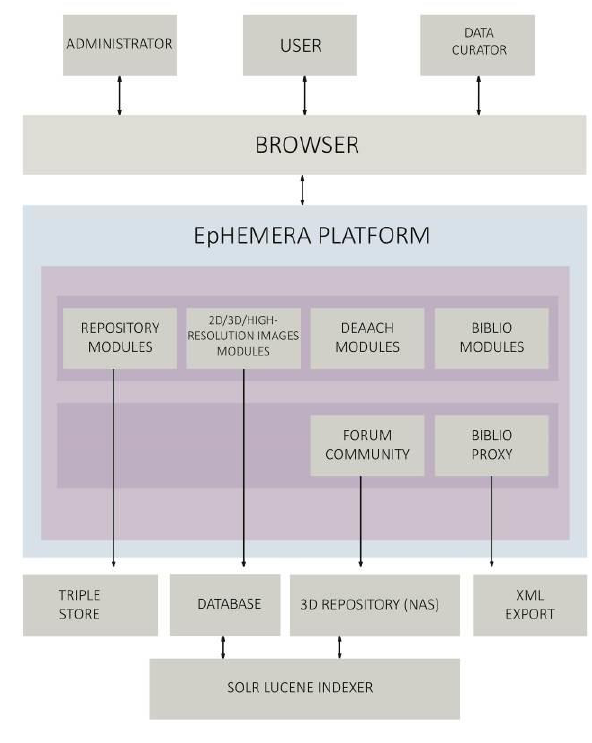
Figure 8: Drupal Database